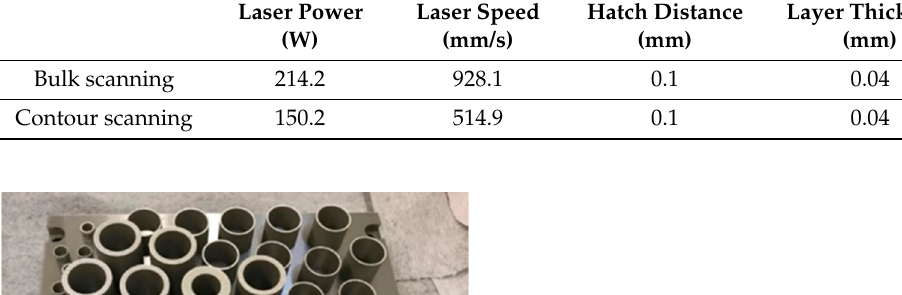
Table 2. Laser processing parameters used for LB-PBF process.